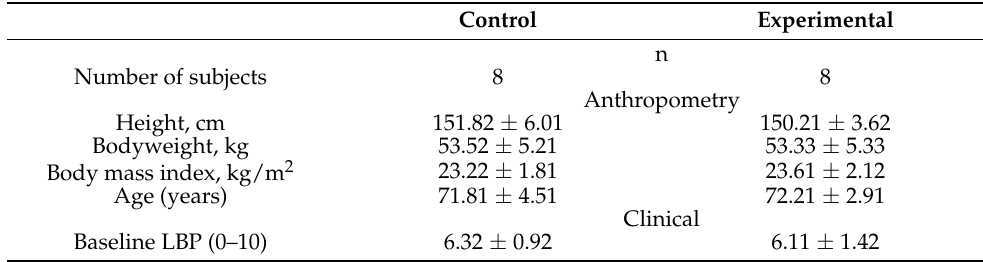
Table 2. Subjects’ anthropometric